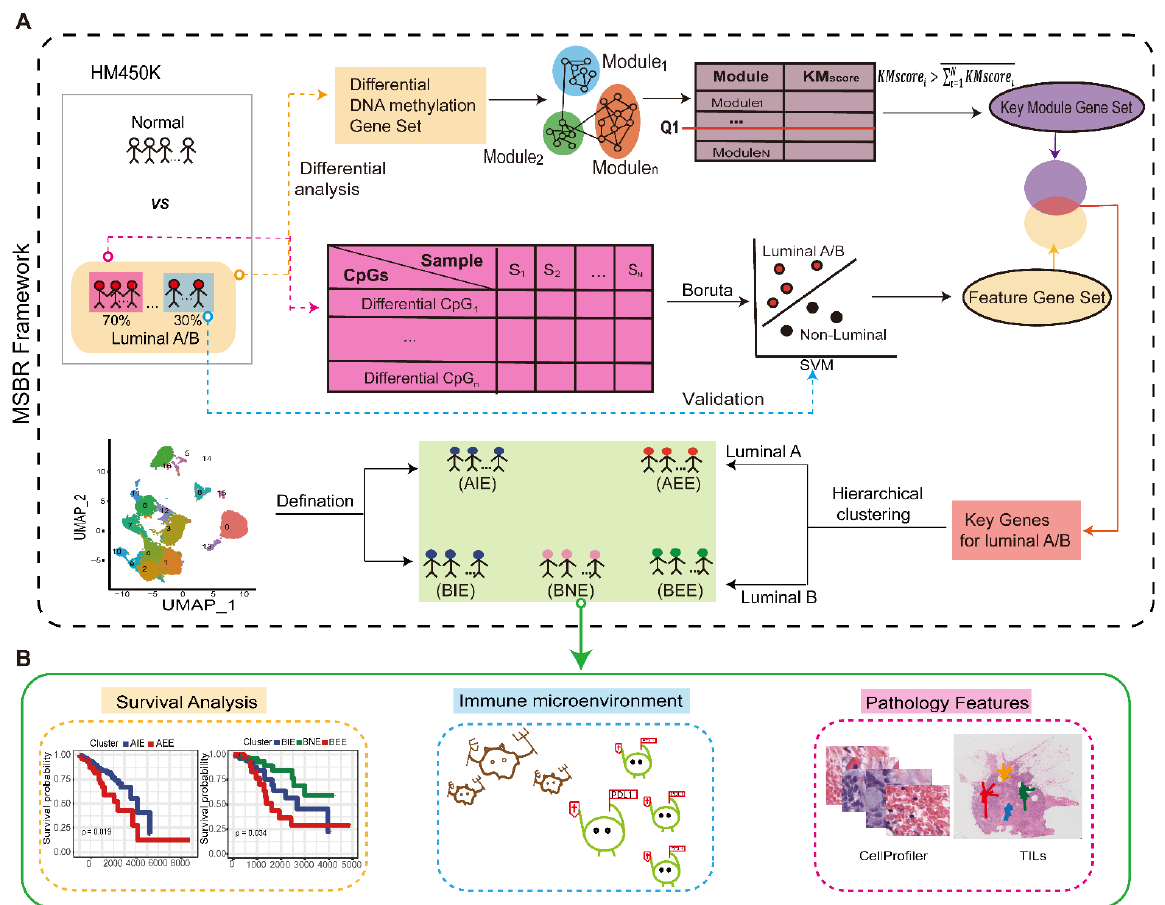
Figure 1. Overview of the Study. ( A ) Workflow of MSBR framework based on key module scoring algorithm and “Boruta” method. ( B ). Analysis of breast cancer subgroups in survival, immune microenvironment, and pathological image features.